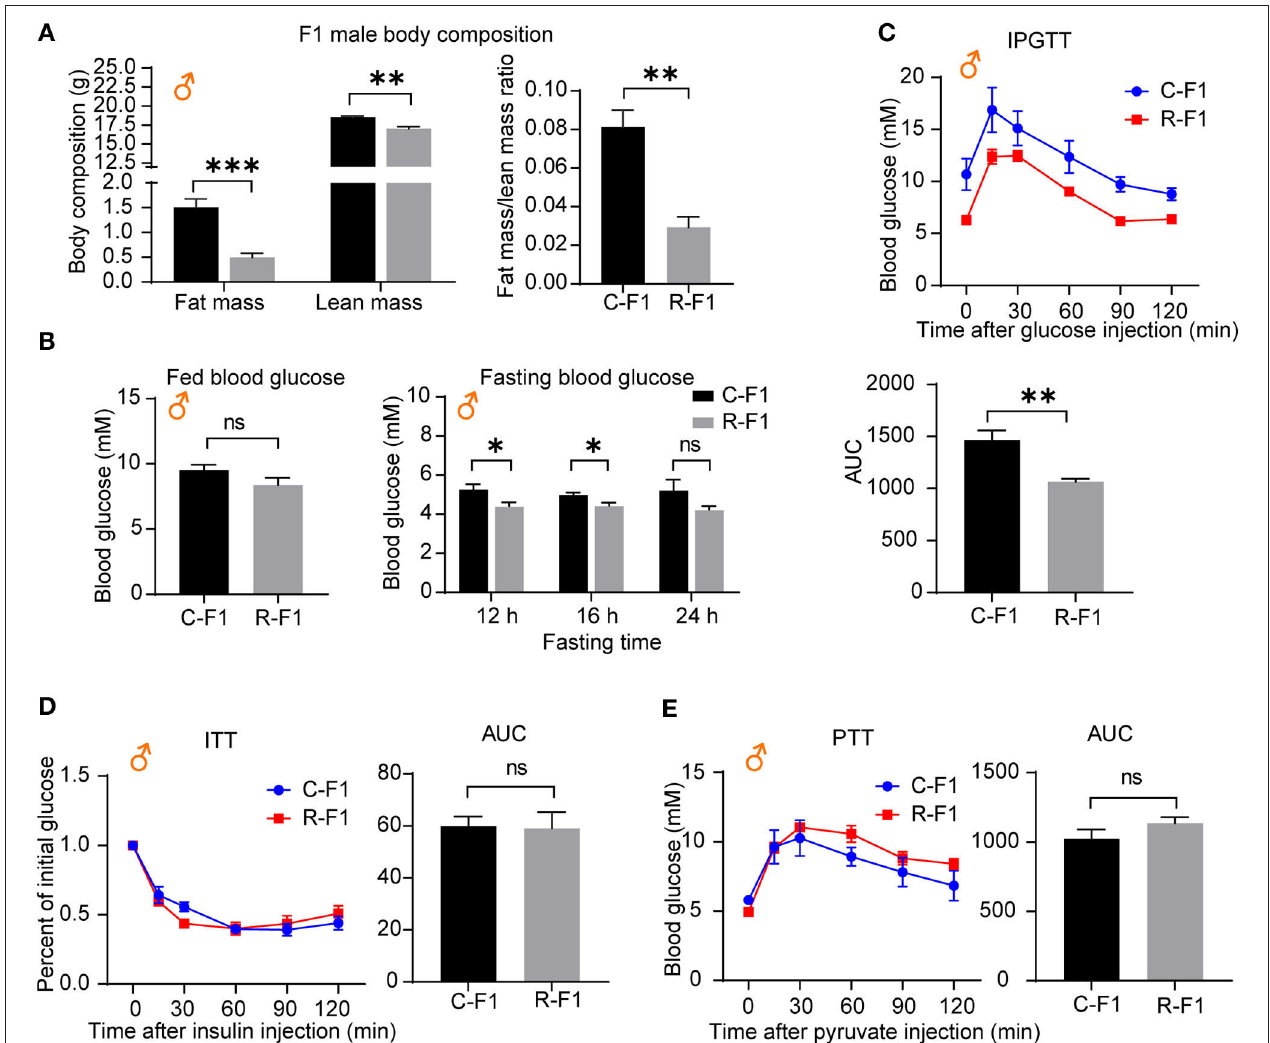
FIGURE 6 | Metabolic profiles in male offspring from exposed fathers are influenced. (A) The body compositions of male F1 mice 45 days after birth. (B) The levels of fed blood glucose and fasting glucose in male F1 mice (7 weeks of age). (C–E) The intraperitoneal glucose tolerance test (IPGTT, 7 weeks of age), insulin tolerance test (ITT, 8 weeks of age), the pyruvate tolerance test (PTT, 9 weeks of age), and the area under the curve (AUC) in the male F1 mice. ns, not significant. (A–E) C-F1, F1 of the control father; R-F1, F1 of the Radiation father. * p < 0.05, ** p < 0.01, *** p < 0.001. n = 6 for both groups. A two-tailed Student’s t -test was performed.